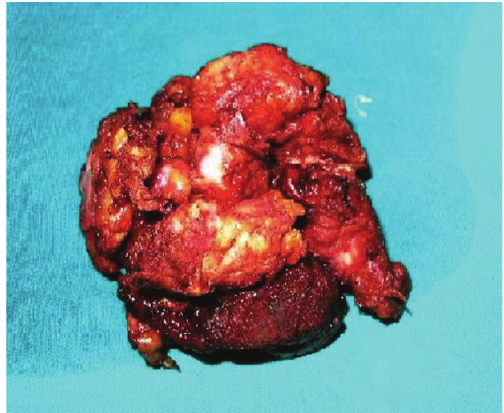
Figure 2: Gross cross-sectional view of pathologyic resected specimen. The gross lesion is poorly circumscribed and usually measures between 5 and 15 cm. On cut section, it is hard and tan- white. The lesion is poorly circumscribed and is centered in skeletal muscle and the adjacent fascia. There often are infiltration and obliteration of adjacent structures.